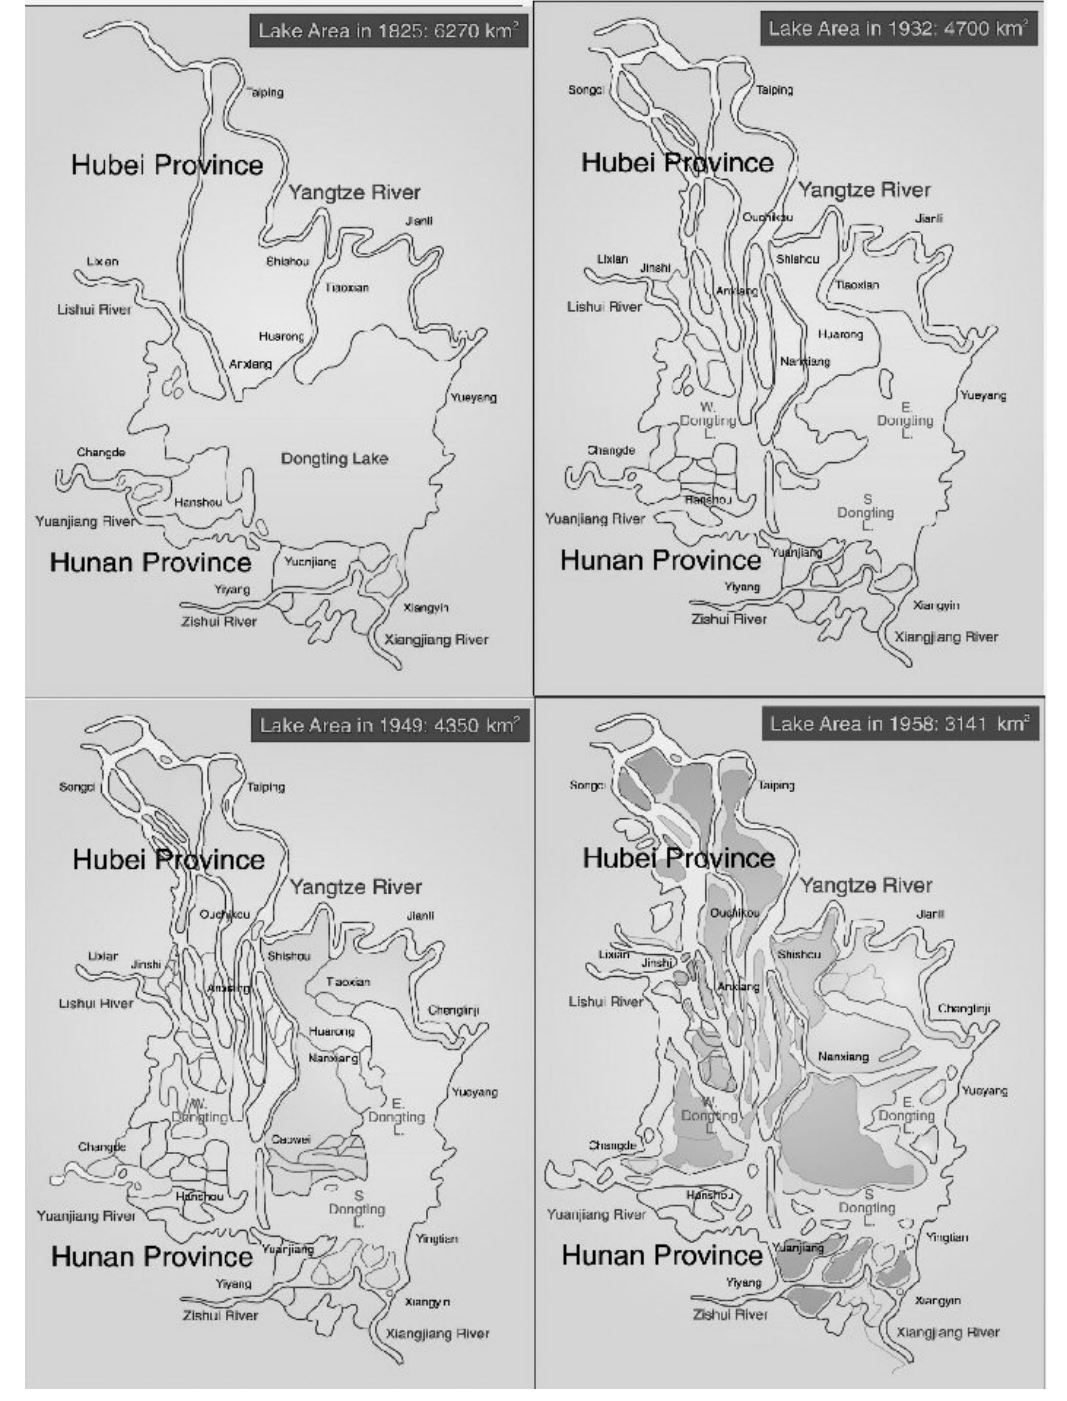
Fig. 3 . Shrinkage of the Dongting Lake area due to land reclamation